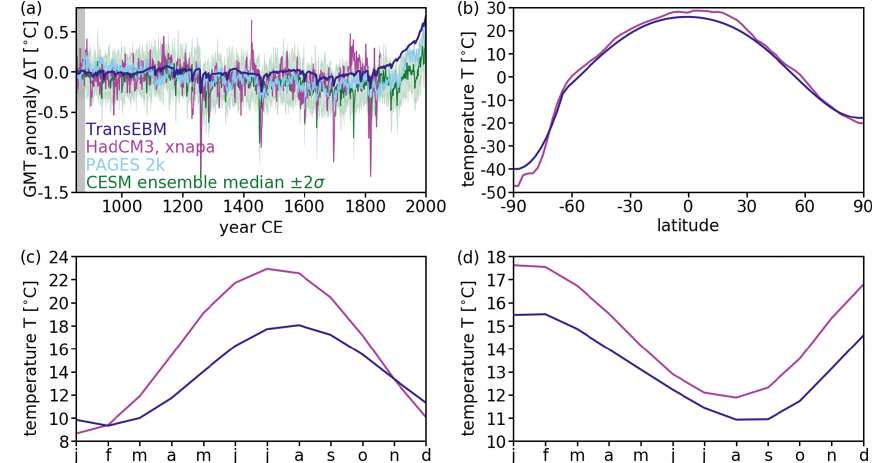
Figure 14. Past millennium simulations and reconstruction. Solar, volcanic, and greenhouse forcings for TransEBM are from Neukom et al. (2019); orbital are parameters set according to Berger (1978); and land, sea, and ice distribution are the same as in Fig. 1. For comparison, the xnapa experiment (ID ◦ xnapa’, unpublished data, K. Rehfeld, Bühler et al., 2020) from HadCM3 (Gordon et al., 2000; Pope et al., 2000) is provided until 1850CE, in addition to GMT in a CESM ensemble (Otto-Bliesner et al., 2016) and a reconstruction for the Common Era (Neukom et al., 2019). Panel (a) presents the GMT anomaly with respect to the climatological means from 850 to 879CE. For CESM, the ensemble median with a spread of 2 standard deviations is shown. The grey shading indicates the reference period. Panel (b) shows the average latitudinal temperature profiles; panels (c) and (d) show the average seasonal temperature profiles for the Northern Hemisphere and Southern Hemisphere, respectively. The overall trends in GMT agree, but HadCM3, CESM and the reconstruction are much more variable. Additionally, HadCM3 and CESM show a stronger response to volcanic forcing. The latitudinal profiles show disagreement only over Antarctica and in the lower latitudes of the Northern Hemisphere. The seasonal cycles disagree, with HadCM3 simulating overall higher temperatures and a larger amplitude in the Northern